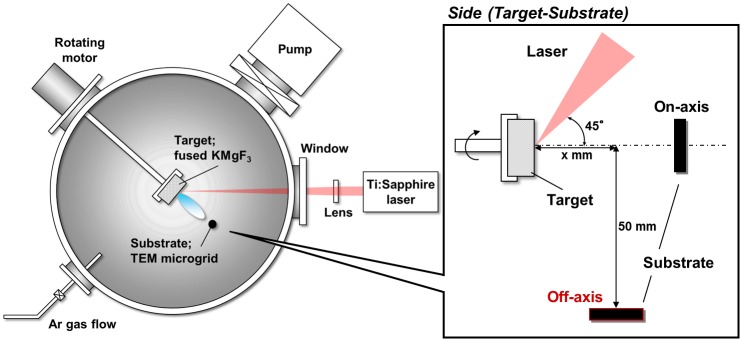
Experimental setup for the fabrication of KMgF3 nanoparticles.